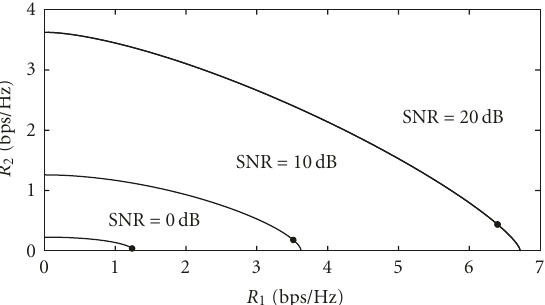
Figure 2: Ergodic rates’ regions for a two-users channel when = g / g 1 2